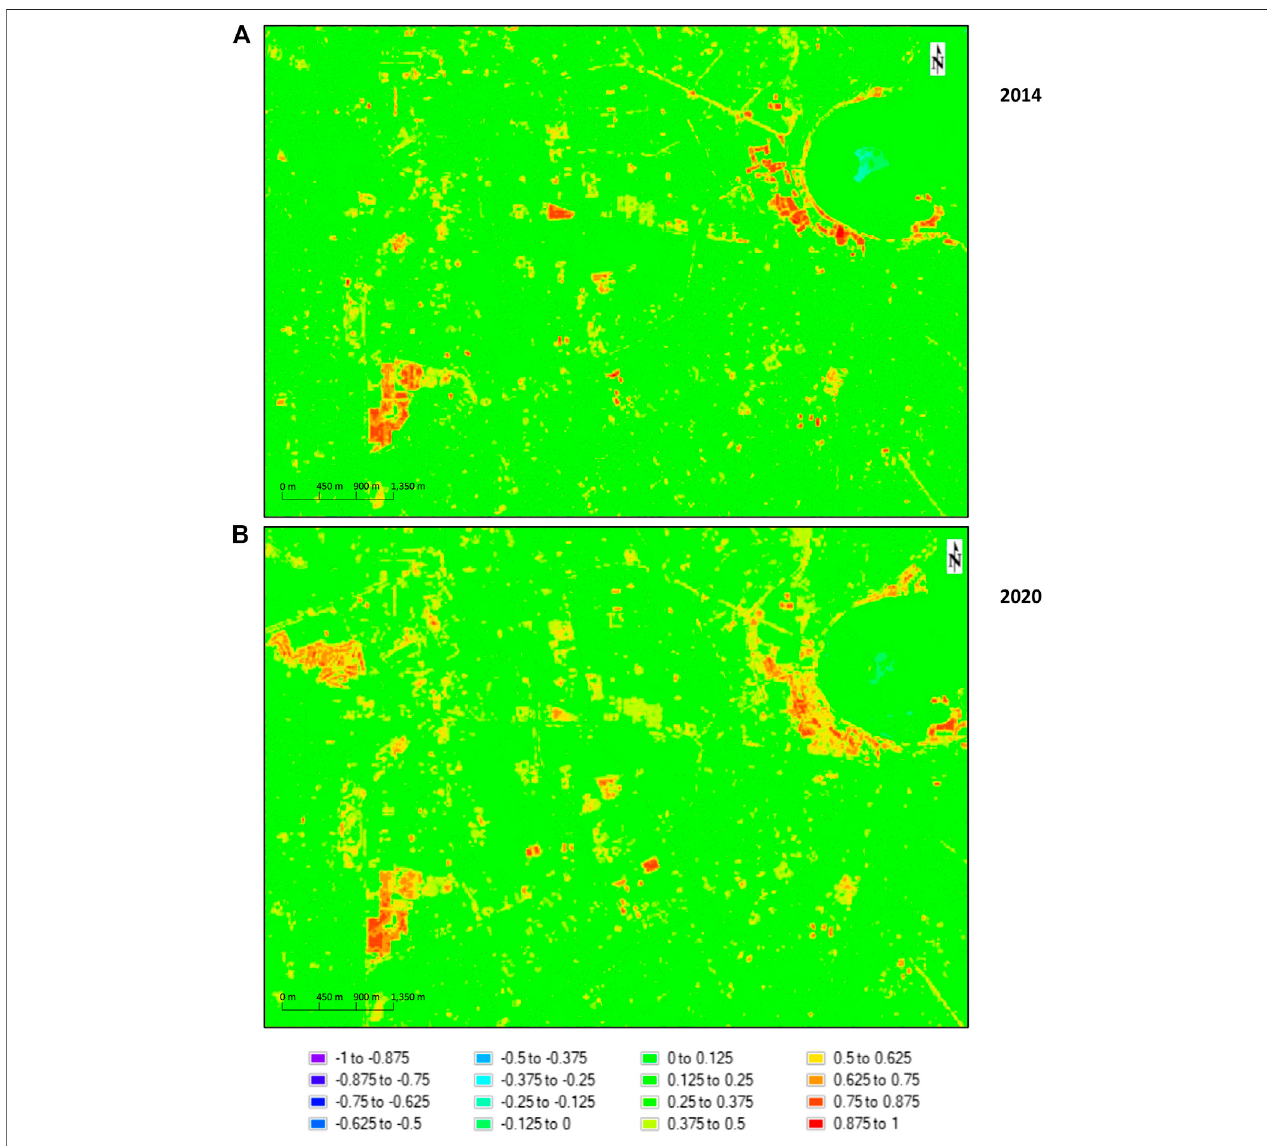
FIGURE 10 | Normalized difference vegetation index (NDVI) maps for Doha city in 2014 and 2020.